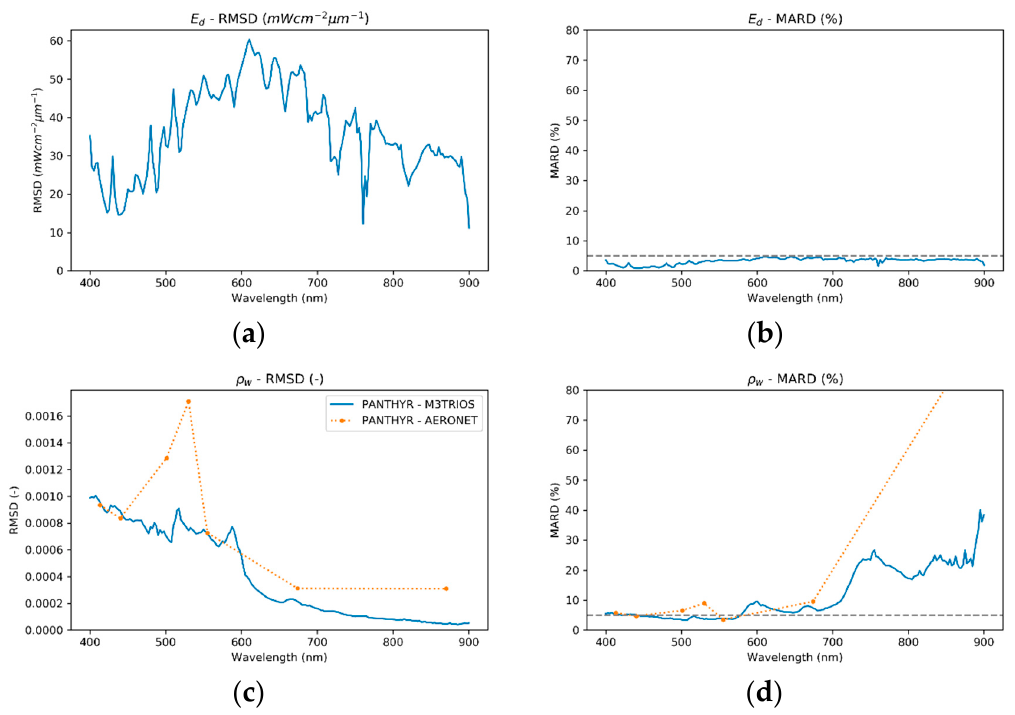
Figure 8. Root-mean-square di ff erence (RMSD) and the mean average relative di ff erence (MARD) between PANTHYR and M3TRIOS systems over 29 stations for ( a , b ) E d , and ( c , d ) ρ w . The 5% MARD is shown as a horizontal dashed line.